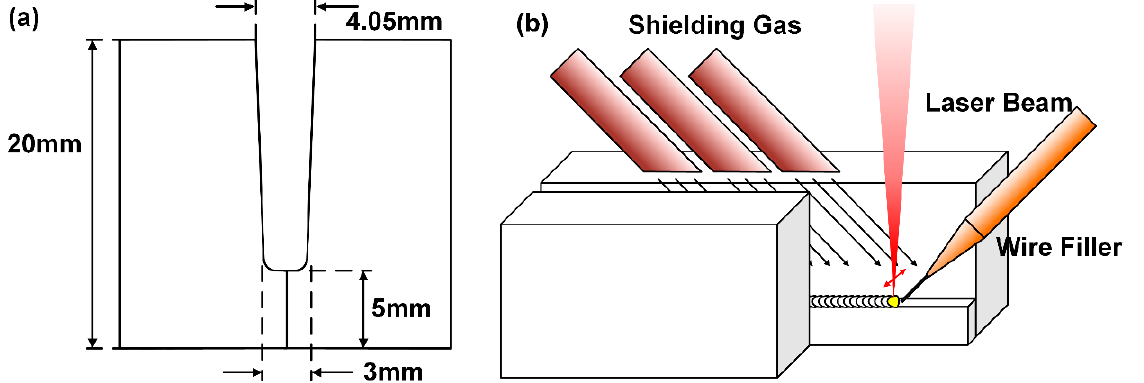
Figure 2. Size of groove design and the schematic of laser NGMP welding with the filler wire. ( a ) Size of groove design; ( b ) welding